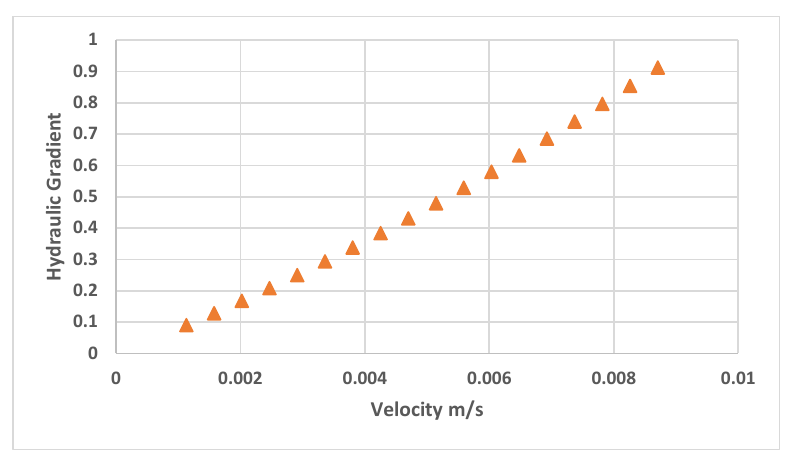
Figure 7. Hydraulic Gradient vs. Velocity for samples 7.